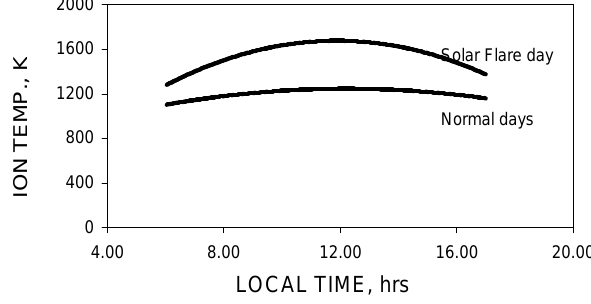
Fig. 8. Diurnal variation of average ion temperature during solar (Fig. 8) flares and normal